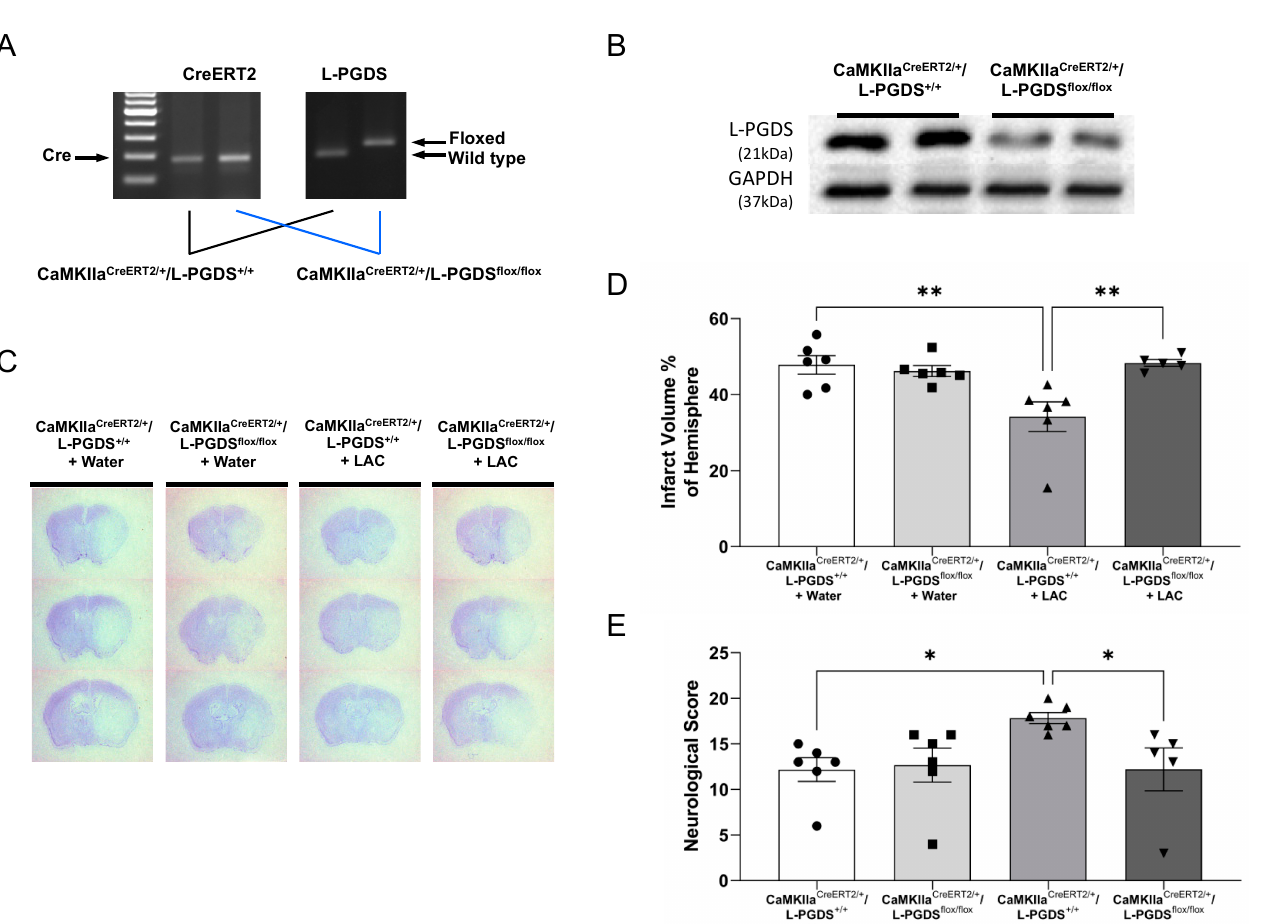
Figure 3. Effect of forebrain neuron-specific L-PGDS knockdown on cerebral I/R injury. ( A ) PCR- based genotyping. The homozygous (fl/fl) mice with Cre positive were considered to be forebrain neuron-specific L-PGDS knockdown mice following tamoxifen treatment. ( B ) Western blots of L- PGDS in the cerebral cortex of tamoxifen-treated CaMKII α CreERT2/+ /L-PGDS +/+ and CaMKII α CreERT2/+ /L- PGDS flox/flox mice. ( C ) Representative brain sections stained with cresyl violet. ( D ) Total infarct vol- ume. ( E ) Neurological deficit score. Values are means ± SEM for 5–6 mice in each group. * p < 0.05. ** p < 0.005. Analyzed using two-way ANOVA followed by Tukey’s test.